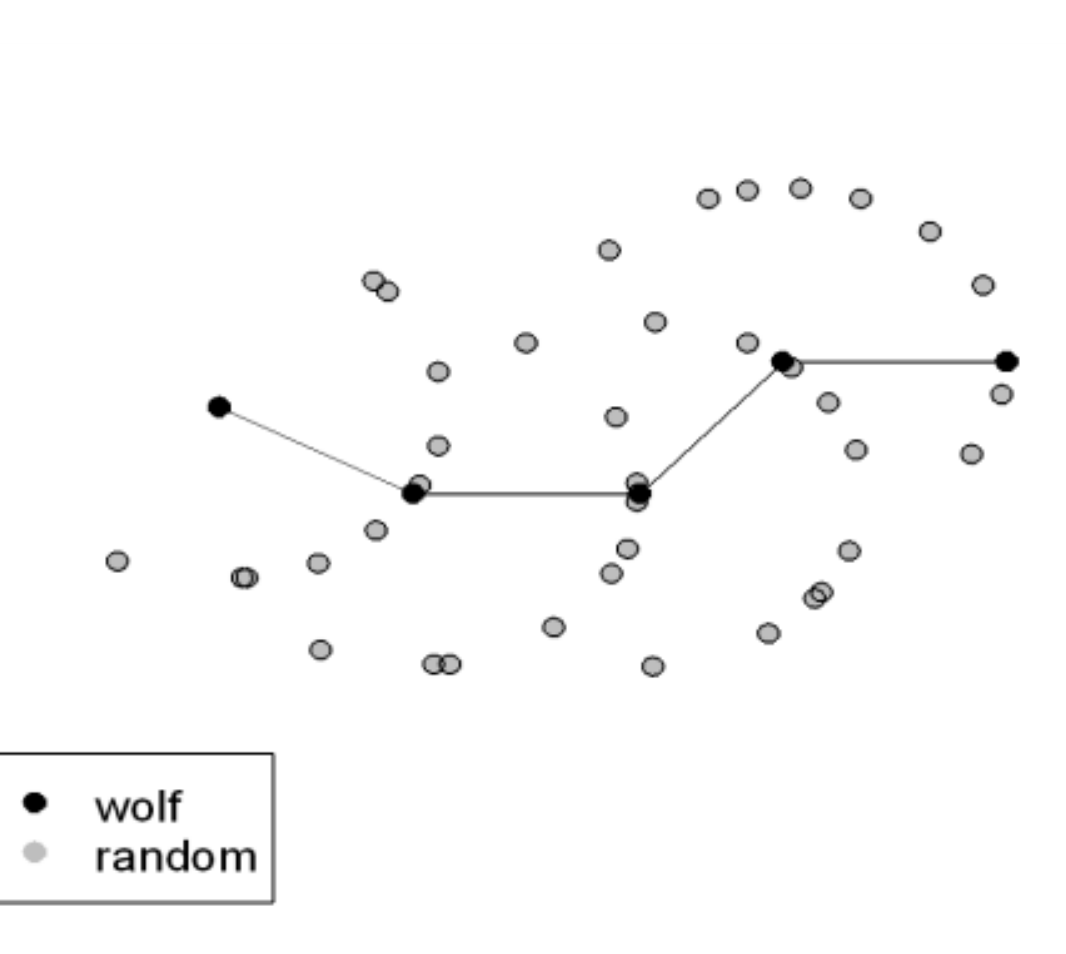
Fig. 2. For the conditional logistic regression, 10 random points were paired with each wolf point. Wolf paths (a) were first simplified into a series of wolf points separated by 500 m (b). To avoid bias potentially associated with the start of each path, we defined the first step as a random point along the first 500 m of the path. To create the controls (c), random turning angles between ± 90 degrees were added to the previous direction of